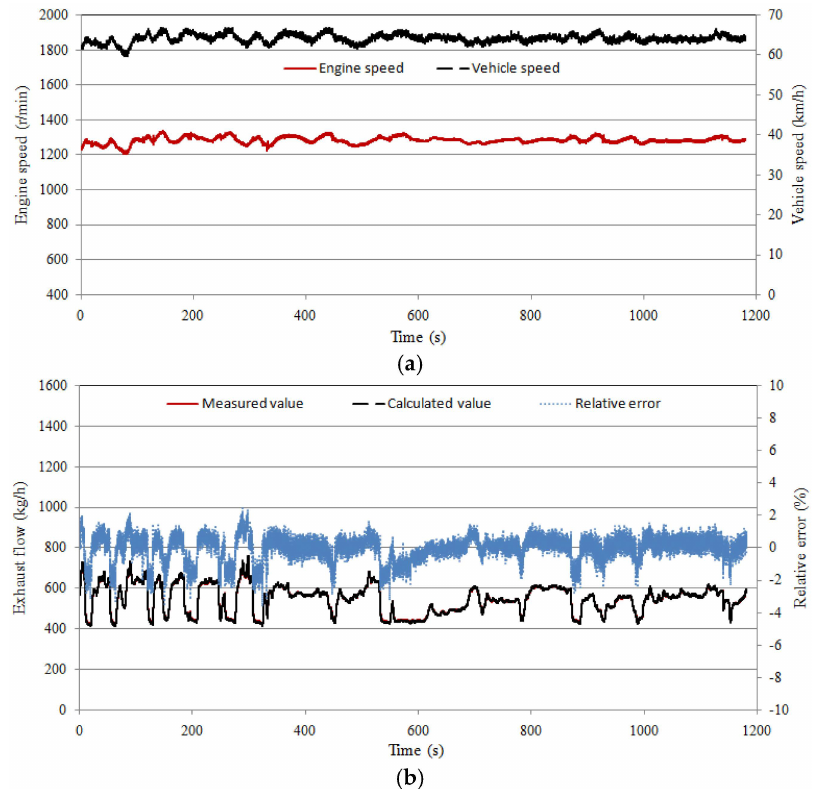
Figure 5. Comparison curve of vehicle actual road exhaust flow under steady-state conditions. ( a ) Engine speed and vehicle speed; ( b ) measured and calculated value of exhaust flow